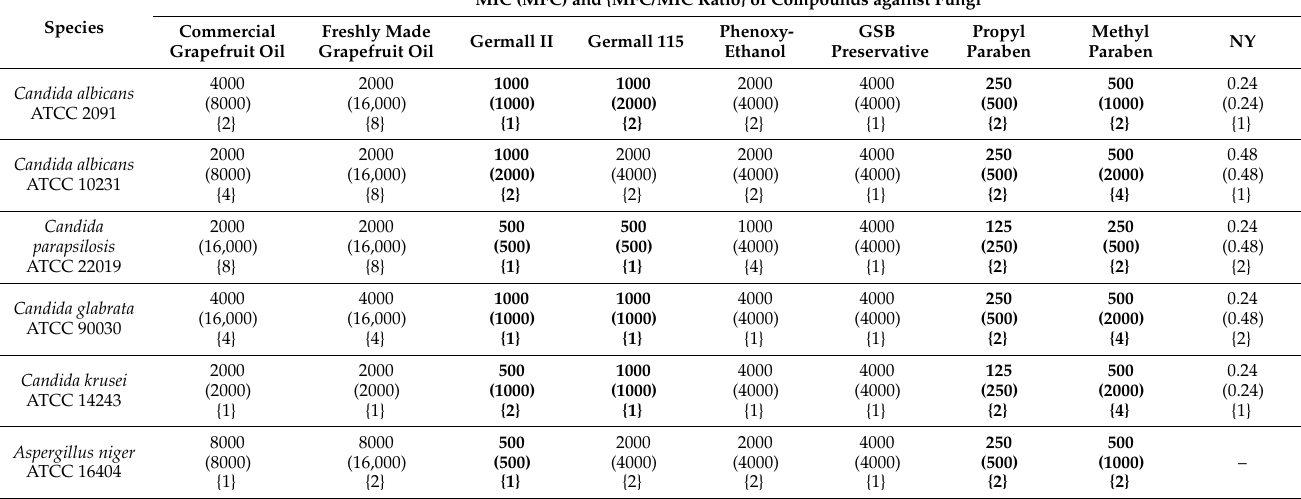
Table 4. The activity data of tested compounds expressed as MIC ( µ g/mL), MFC ( µ g/mL), and MFC/MIC ratio against the reference strains of